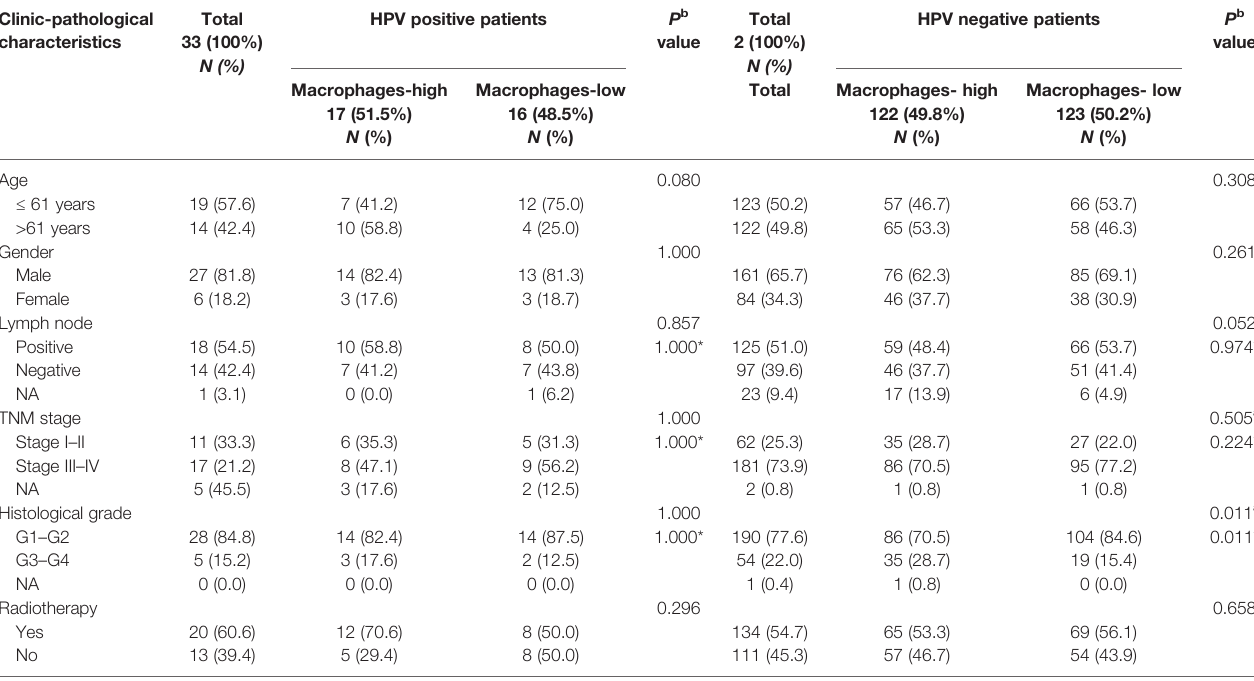
TABLE 3 | Correlation of macrophage in fi ltration deconvolved using CIBERSOFT with clinic-pathological characteristics of HPV positive and negative OSCC patients in TCGA cohort. Clinic-pathological